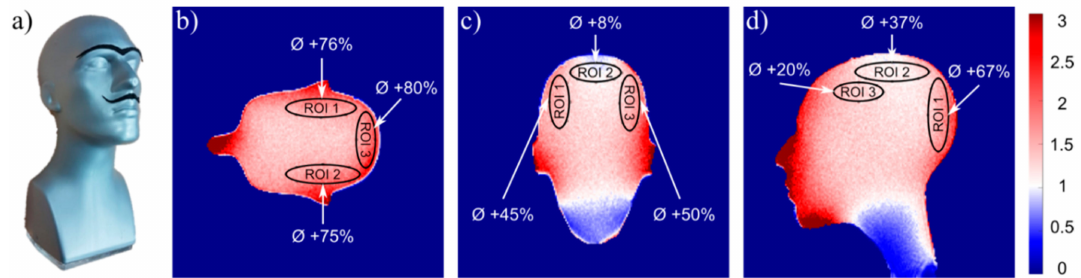
Figure 7. SNR gain of the 24-channel PET / MR coil array versus the 16-channel commercial reference coil. ( a ) Photograph of the head-shaped gel phantom used for measurements, ( b ) central coronal slice, ( c ) central sagittal slice, and ( d ) central transversal slice. The mean relative SNR gain (red) is indicated for each region-of-interest (ROI). Losses are shown in